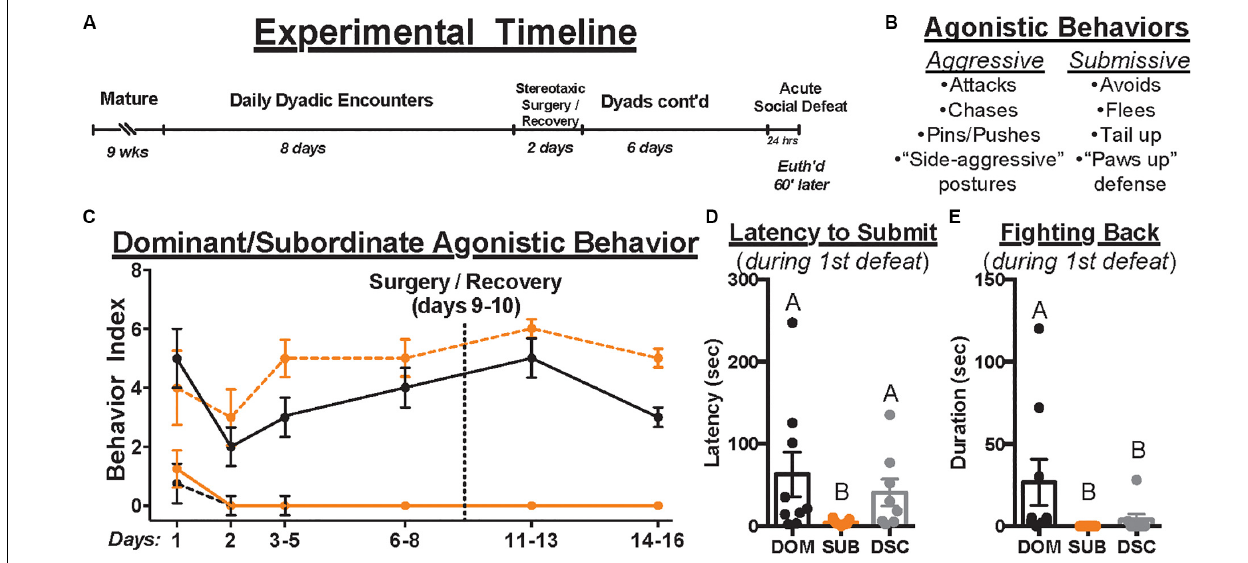
FIGURE 1 | The experimental timeline is depicted in (A) . Upon maturation, male Syrian hamsters were assigned to a dyad with a weight- and age-matched conspecific and paired 5 min daily for a total of 14 days. Dyads were paused on days 9–10 to permit stereotaxic injection of retrograde tracer, CTB, directly into the DRN. Control hamsters remained group housed until surgery but were individually housed immediately afterward and until euthanasia. After surgical recovery, daily dyadic encounters resumed on days 11–16 where applicable. On day 17, all animals received acute social defeat or no-stress control procedures followed 60 min later by euthanasia to time-lock cFos expression within stress-activated neurons (i.e., 90 min following the start of defeat episodes). During dominance and defeat encounters, aggressive and submissive behaviors were scored per the ethogram summarized in (B) . The occurrence of each behavior was recorded daily to index dominance status over time (C) . Black and orange lines indicate summated behaviors of dominants and subordinates, respectively. Solid and dashed lines indicate aggressive and submissive behaviors, respectively. Importantly, once dominance relationships were formed on day 1, hierarchies remained stable throughout the remainder of daily encounters. In response to the first of three social defeat encounters with a resident aggressor on day 17, the latency to submit (D) and duration of fighting back (E) were quantified. Dominants (DOM) took longer to submit than subordinates (SUB) and spent more time fighting back than SUB and dominance status controls (DSC). Letters above each bar indicate statistical significance only where different (i.e., “A” differs from